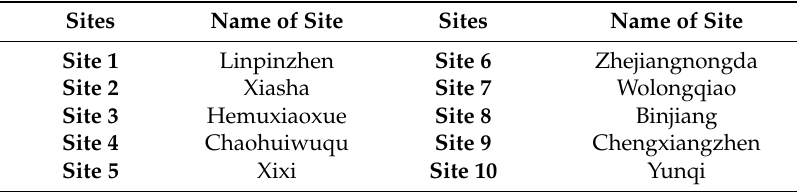
Table 1. List of monitoring sites in Hangzhou,